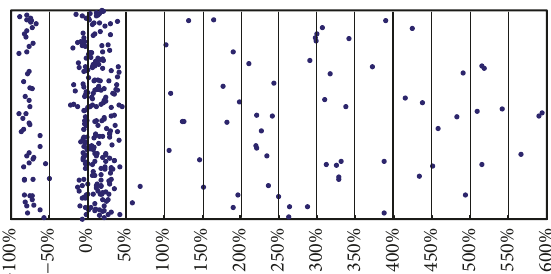
Figure 7: Diagram of prediction error